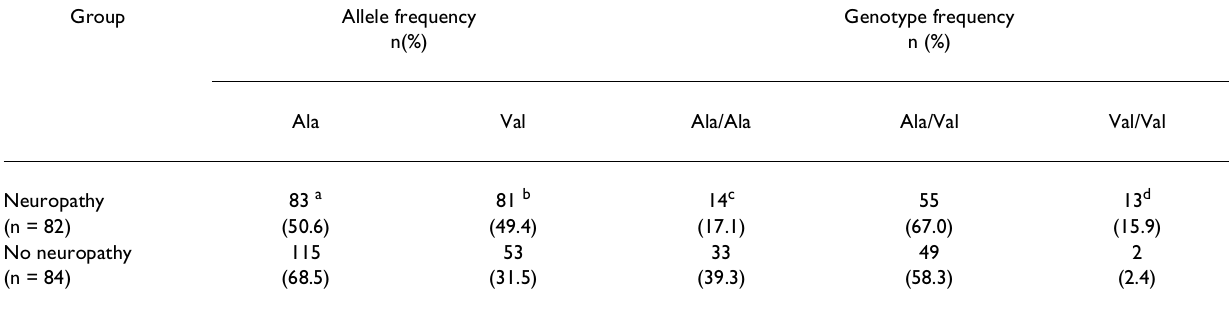
Table 3: Allele and genotype distribution of the Ala(-9)Val Mn-SOD polymorphic marker in type 1 diabetic patients with and without neuropathy Group Allele